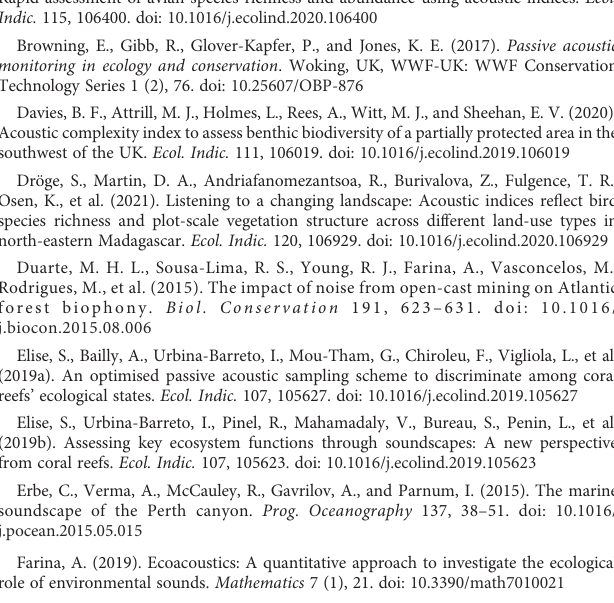
SUPPLEMENTARY TABLE 1 Summary of all combined annotations and acoustic indices results used to